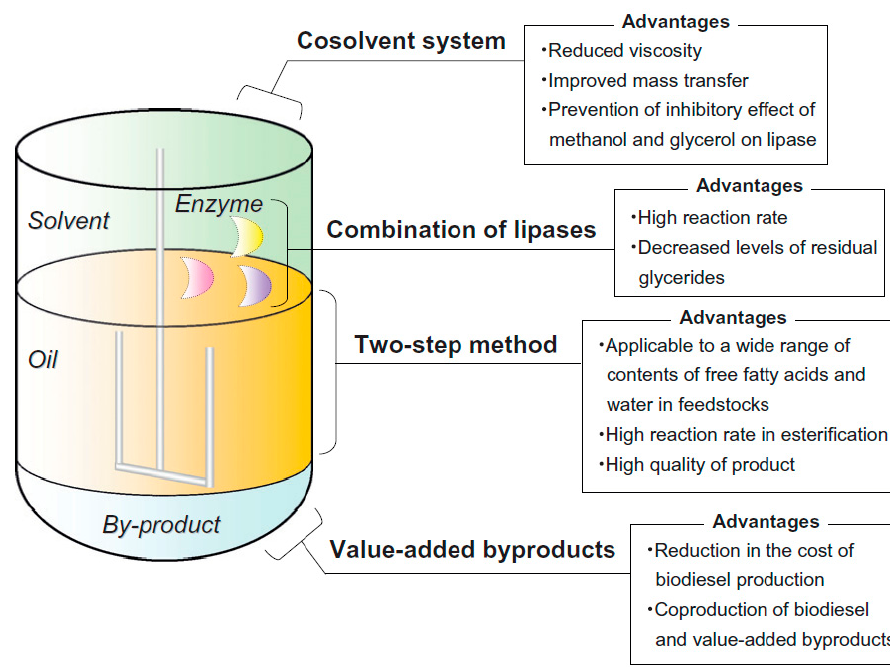
Figure 1. Schematic of approaches to increasing enzymatic biodiesel production [53].